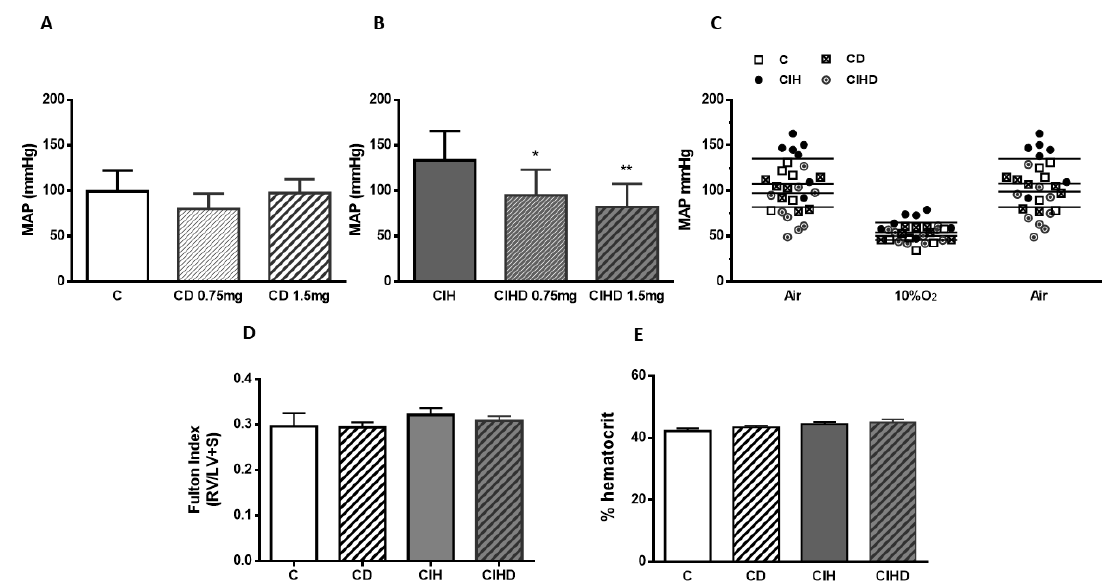
Figure 2. Chronic effect of domperidone on arterial blood pressure. In ( A , B ) chronic effect of DOM (0.75 or 1.5 mg / day; 15 days) on MAP from C ( A ) and CIH ( B ) rats. Data are mean and SD from 6—10 animals. * p < 0.05 and ** p < 0.01 vs. CIH; One-way ANOVA with Tukey’s multiple comparisons test. In ( C ) individual measures of MAP from the four group of animals (DOM 0.75 mg / day; 15 days) in basal (air), hypoxia test (10% O 2 ), and recovery conditions from 5–7 animals. In ( D , E ) Fulton index and hematocrit values from the four group of animals. Data represented as mean and SD from 6–10 individual